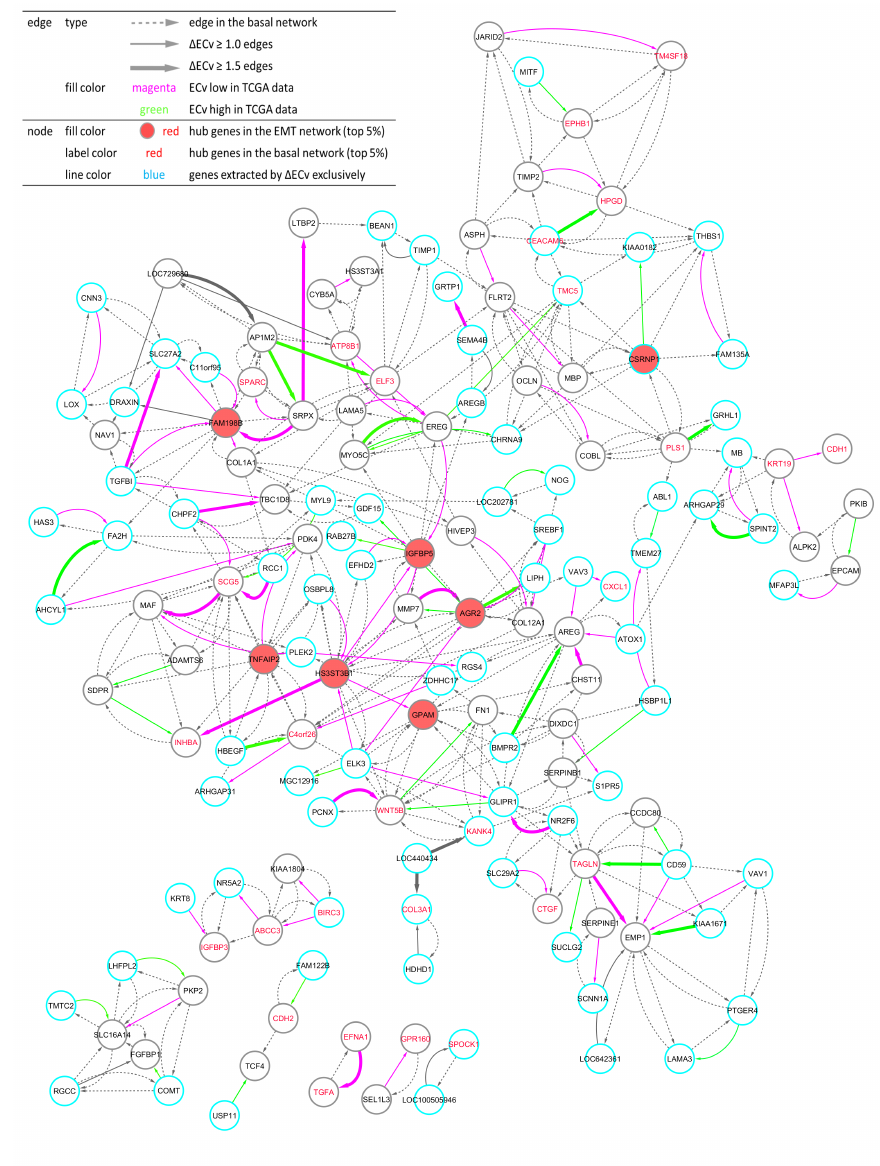
Figure 4. Visualization of the EMT network. One hundred and fifty nodes and 411 edges constitute the network. The total number of connected components is seven. Node: The top 5% hub genes (filled with red) in the EMT network, and the top 5% (labeled with red) hub genes in the basal network are displayed. Nodes (blue line) represent genes extracted by ∆ ECv exclusively. Edge: Bold edges (grey) and standard edges (grey) represent ones with absolute ∆ ECv more than 1.5 and 1.0, respectively. ECv high 38 (green) and low (magenta) 70 edges in TCGA data-fitting experiment (Figure 6A and Figure S3B) are labeled. Dotted edges (grey) originally belonged to the basal